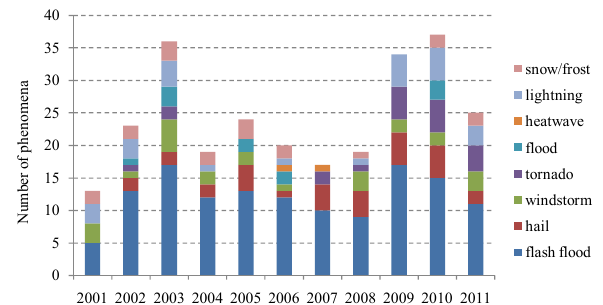
Fig. 10. Distribution (%) of weather-related phenomena by type of phenomenon and impact intensity (2001–2011).